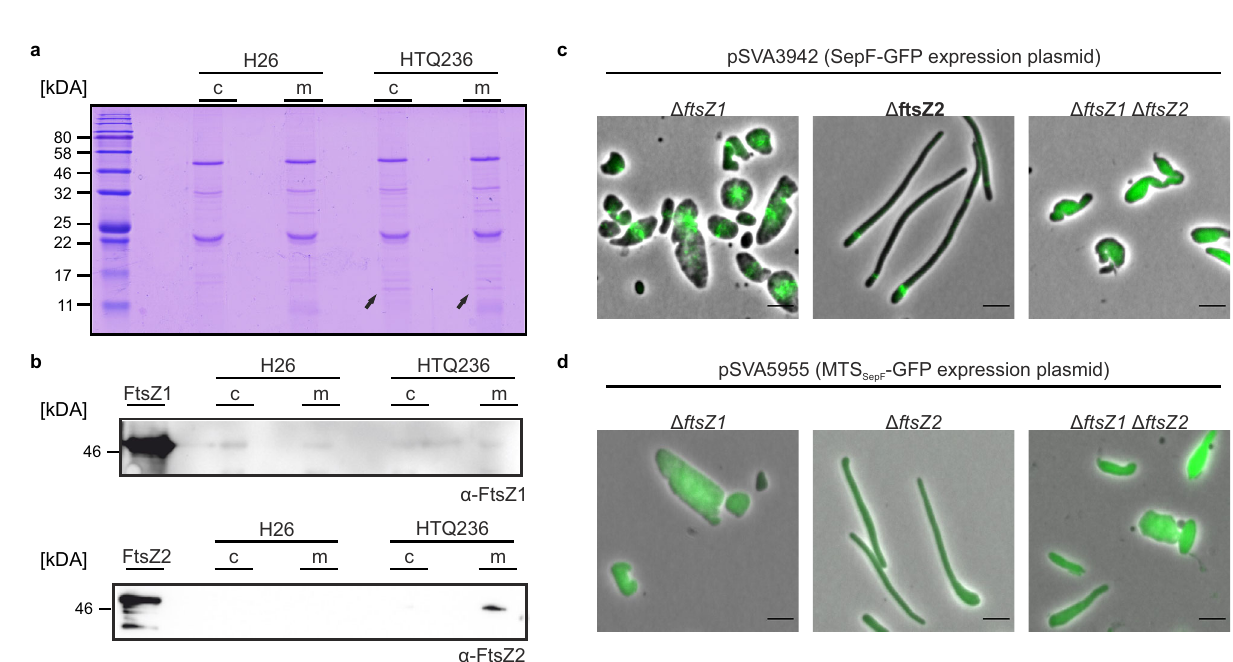
Fig. 7 Localization of FtsZ1 and FtsZ2 in SepF-depleted cells. a First row: Fluorescence microscopy of HTQ239 cells additionally expressing ftsZ1 - gfp under the control of its native promotor at different time points (0, 3, 6, 9, and 24 h) after SepF depletion. Middle row: Cell length in relation to the number of FtsZ1 rings assembled per cell. Over time the cells became fi lamentous and the number of FtsZ1 rings increased up to nine rings in the most elongated cells. Third row: Distribution of FtsZ1 rings amongst the analyzed cells at the indicated time points after SepF depletion. b First row: Localization of FtsZ2- GFP by fl uorescence microscopy in HTQ239 at different time points after SepF depletion. Middle row: Cell length in relation to the number of FtsZ2 rings assembled per cell. Cells became fi lamentous over time and the number of FtsZ2 rings partially increased up to three rings per cell. Third row: Distribution of FtsZ2 rings amongst the analyzed cells at the indicated time points after SepF depletion. The plots summarize the results from three independent experiments per strain and timepoint after depletion. In the box plots, minimum and maximum values are indicated by the whiskers, the median is indicated by a horizontal line and the mean by a + . Scale bars: 4 µ m.